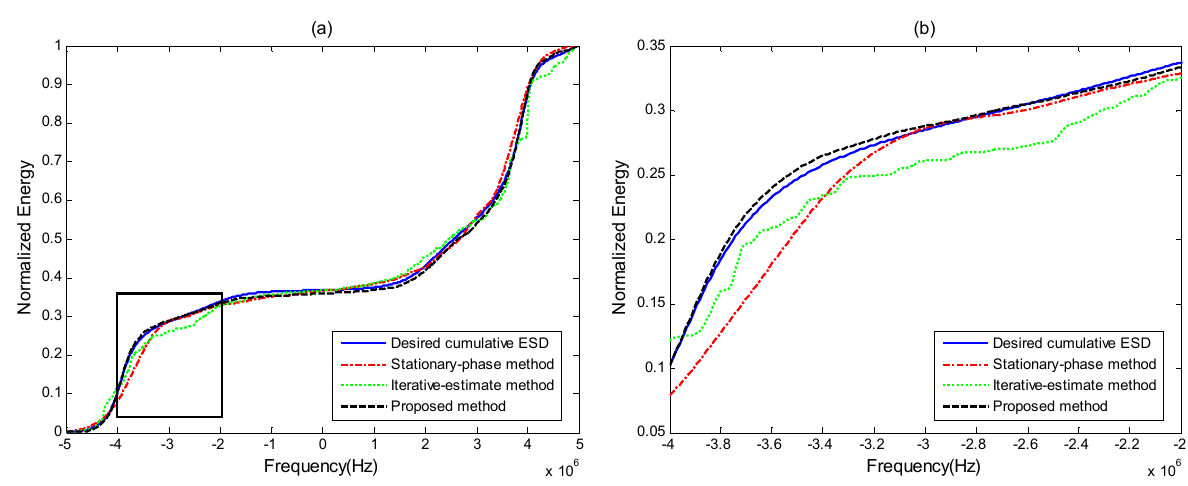
Figure 4. Comparison of the normalized cumulative ESD of signals synthesized using different methods for (a) the full passband and (b) the zoomed version of the section highlighted in a